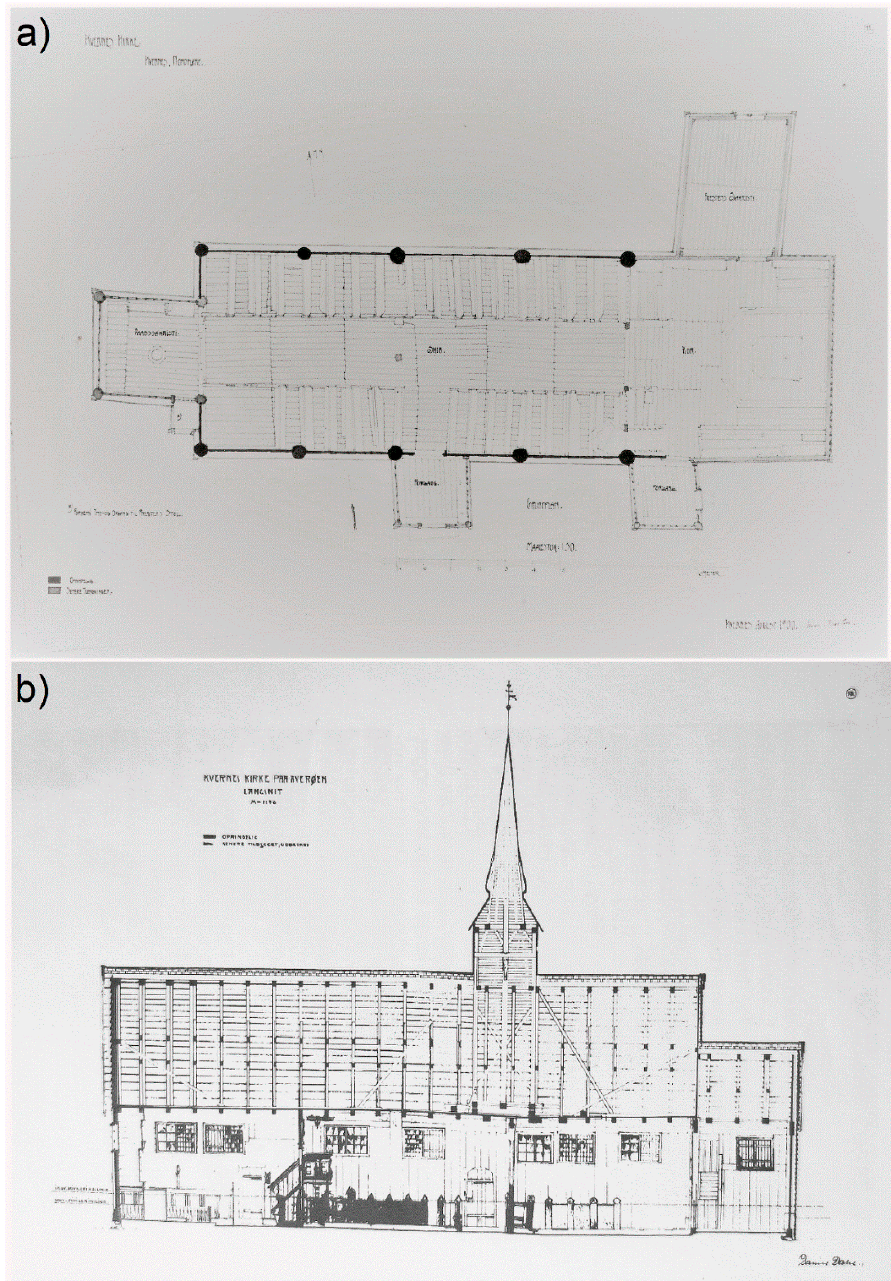
Figure 2. Kvernes stave church. ( a ) Planimetry; ( b ) vertical section. The south wall. Source: Illustrated guide to the stave church by the architect Heinrich Joachim Sebastian Karsten (1873–1947) in 1900.